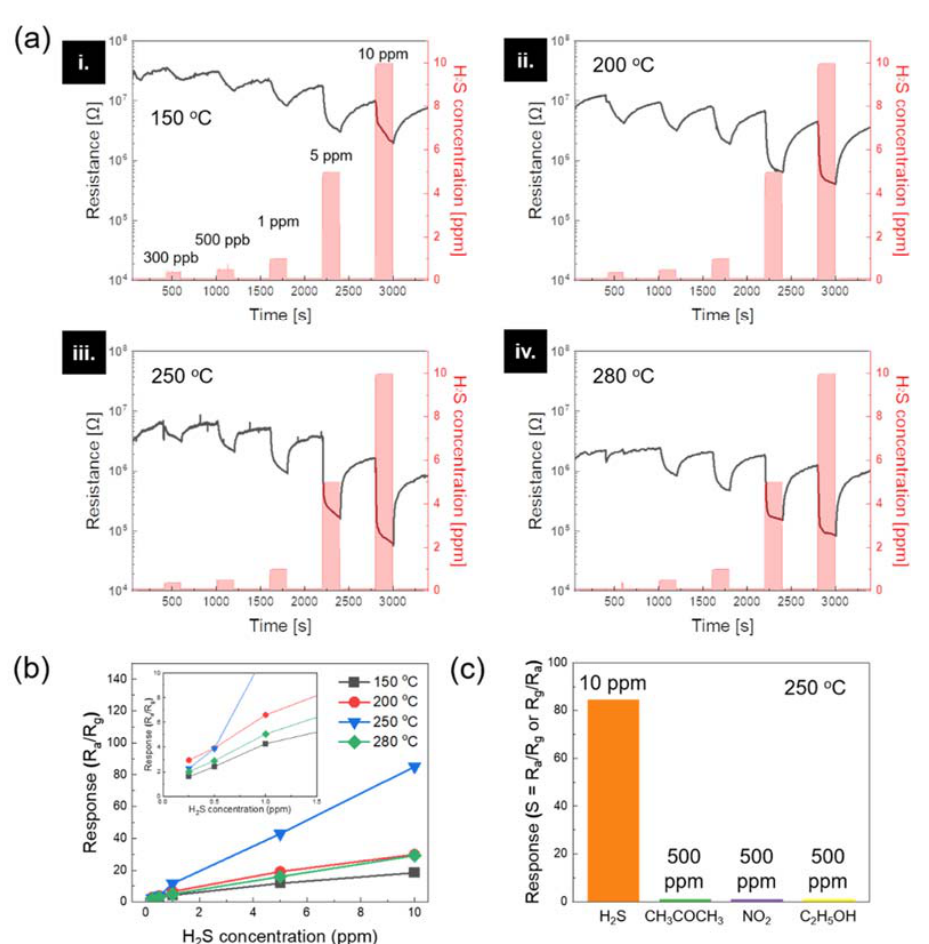
Figure 3. ( a ) H 2 S gas sensing performances of the ZnO ‐ ZnFe 2 O 4 hollow nanofibers with different gas concentrations from 300 ppb to 10 ppm with different operating temperatures of 150, 200, 250, and 280 °C. ( b ) Response ‐ concentration fitting curves regarding operation temperature